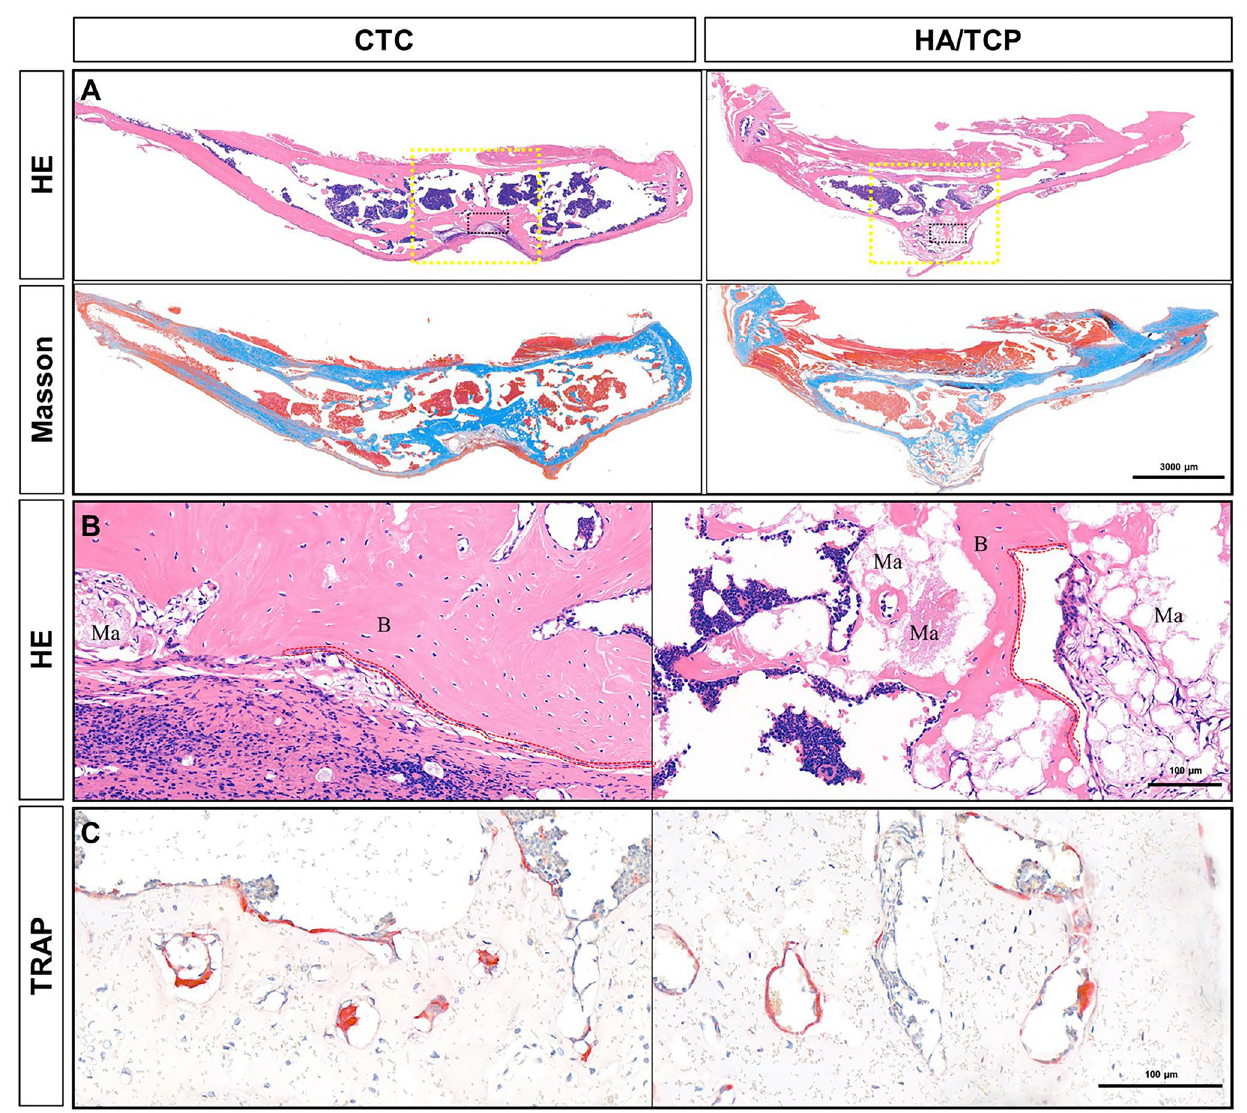
Figure 7. The microstructure of repairing tibia defects in mice. ( A ) The HE and Masson’s trichrome staining showing the bone repair after filling the 4-mm tibia defects with the CTC composites and HA/TCP biomaterials. Yellow dotted box: the implanted material sites; black dotted box: being enlarged to figure B; bar: 3000 μm. ( B ) Enlargement of figure A, observation of osteoblasts bone tissues and materials, red dotted line: osteoblasts; B bone tissues, Ma non-degraded materials; bar: 100 μm. ( C ) The TRAP staining showed osteoclast formation in the new bone tissues, bar: 100